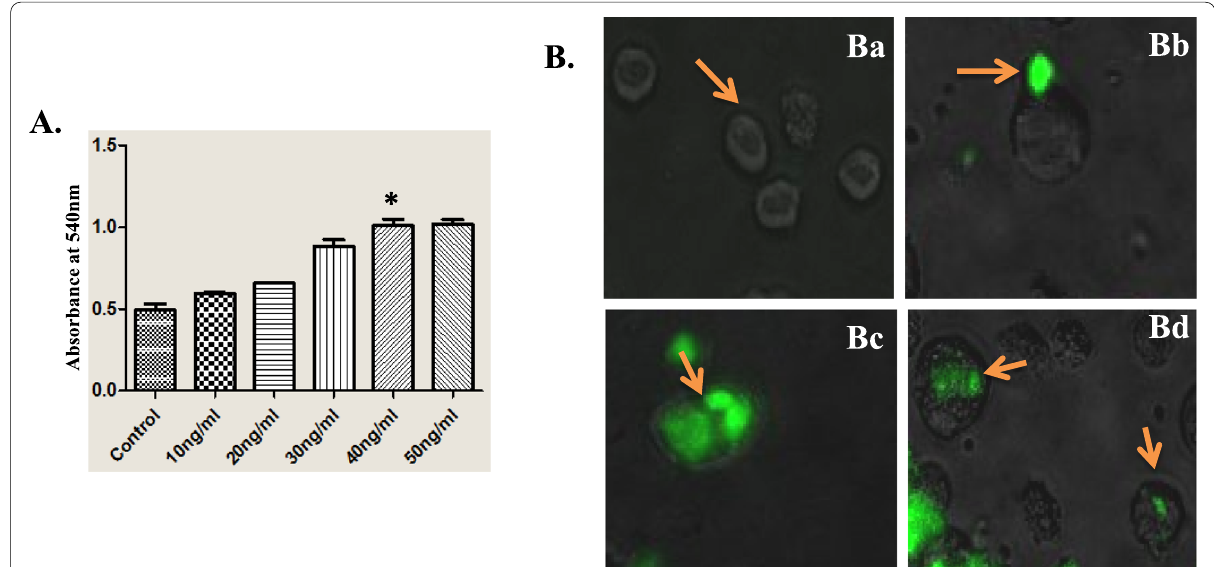
Fig. 4 MTT reduction and phagocytic assays for BuLIF on M1 cells. A For MTT assay, M1 cells were culture for 24 h with and without BuLIF and BuLIF (0–50 ng/ml). The reduction of MTT was dependent on the dose of BuLIF. Stimulated M1 cells showed high dehydrogenase activity in comparison to control M1 cells, p < 0.05. B For phagocytosis assay, M1 cells were treated for 4 days with and without BuLIF (40 ng/ml) and incubated with fluorescent latex beads for 24 h at 37 °C. Ba , Bb Unstimulated M1 cells were not phagocytic; Bc , Bd M1 cells were phagocytic and engulfed two to three FITC conjugated latex beads. Magnification, ×